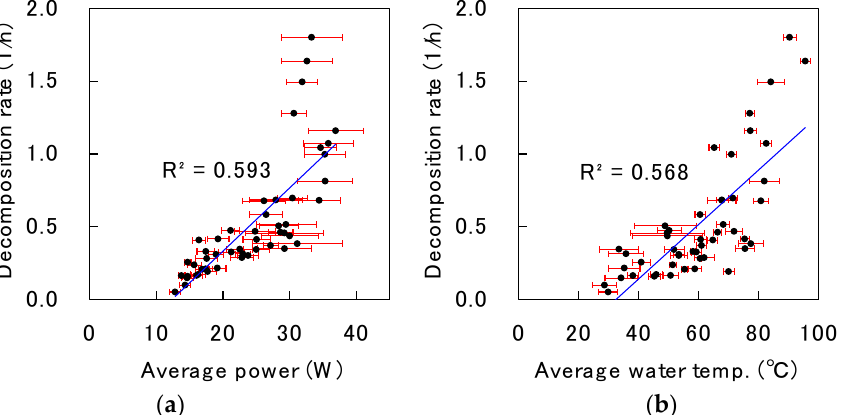
Figure 4. Decomposition rate constant of sucrose (10 g/L) in solution plasma as a function of the ( a ) average power and ( b ) average water temperature. Error bars indicate sample standard deviations for power and water temperature distributions.